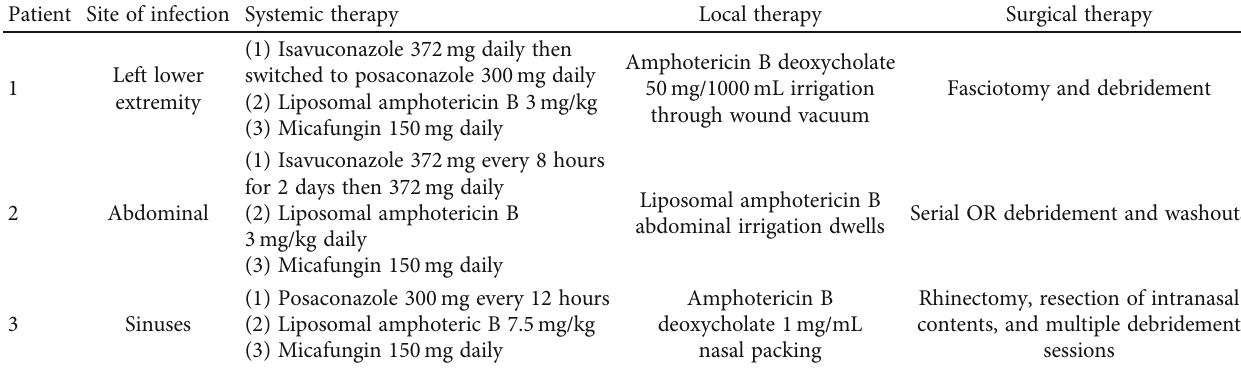
Table 6: Summary of presented